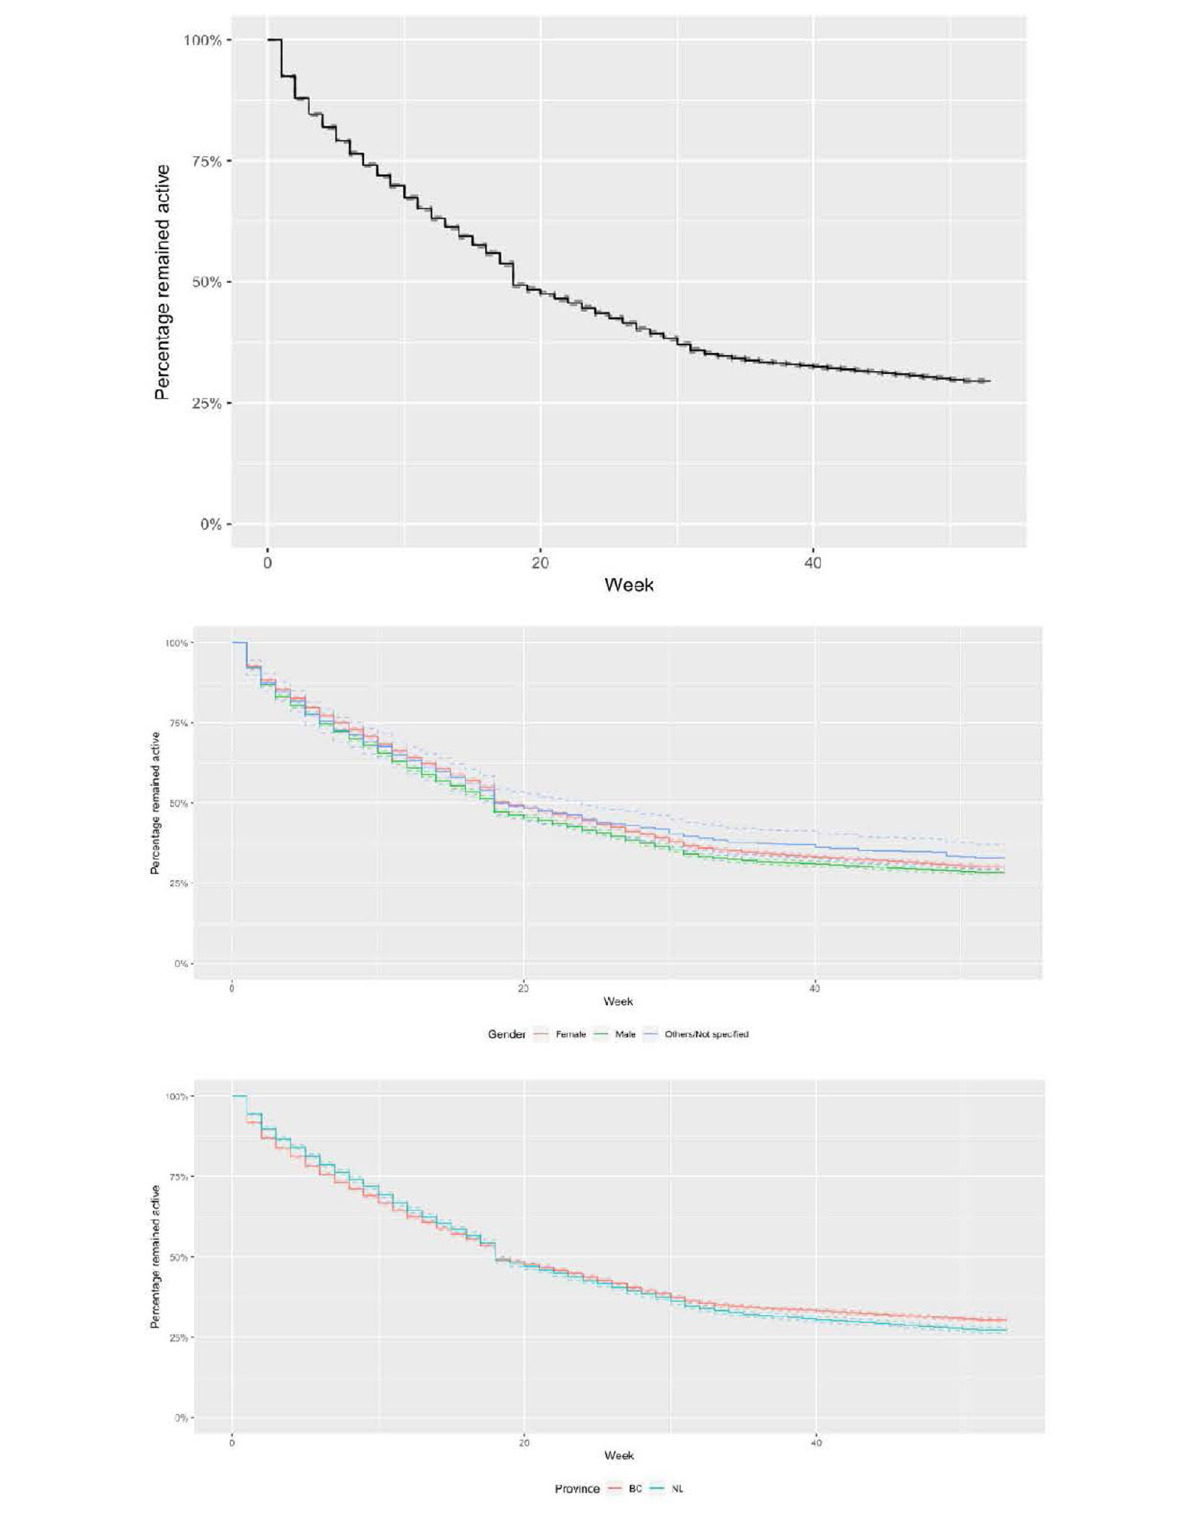
FIGURE2 Kaplan-Meier estimates of the survival distribution for time to the first break for the total sample (top) by gender (middle) and by province (bottom)